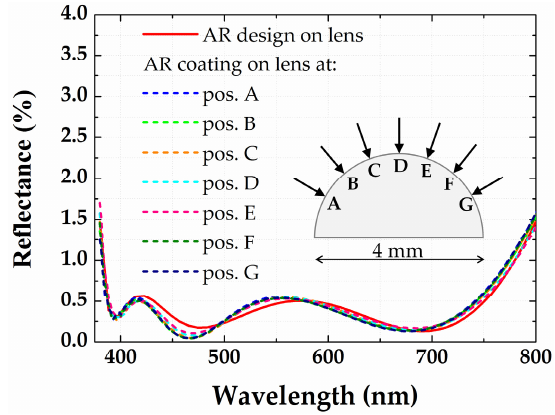
Figure 7. Measured and expected reflectance spectra (AOI = 0 ◦ ) of AR-coated fused silica half-ball lens at different positions of the lens.